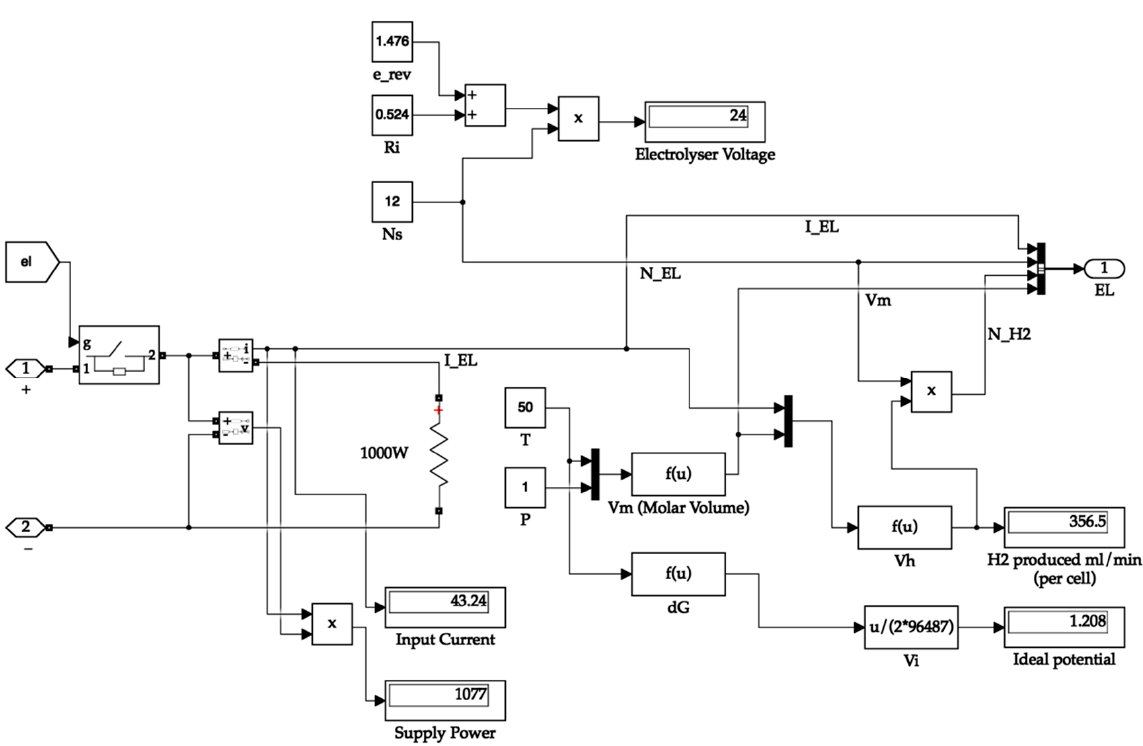
Figure 7. Electrolyser system.